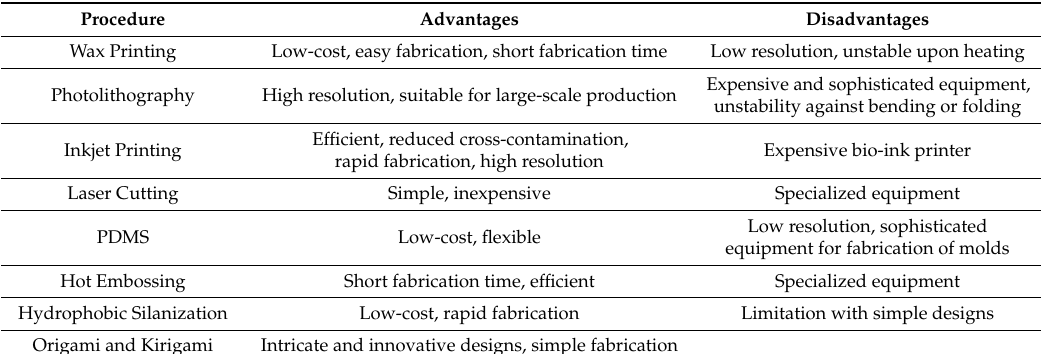
Table 1. Advantages and disadvantages of the main fabrication techniques for paper-based